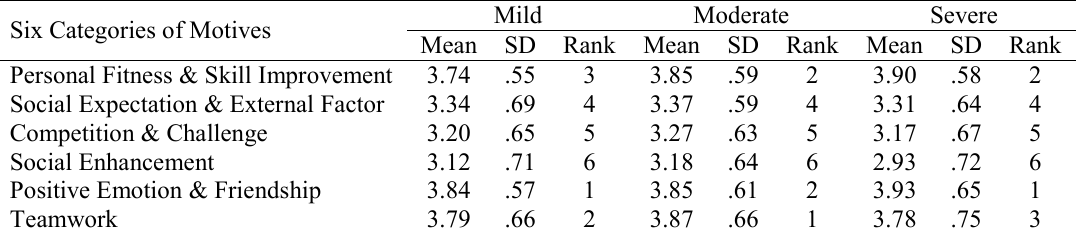
Table 2 Descriptive Data for Severity of Impairment on the Revised Exercise Participation Motives Questionnaire